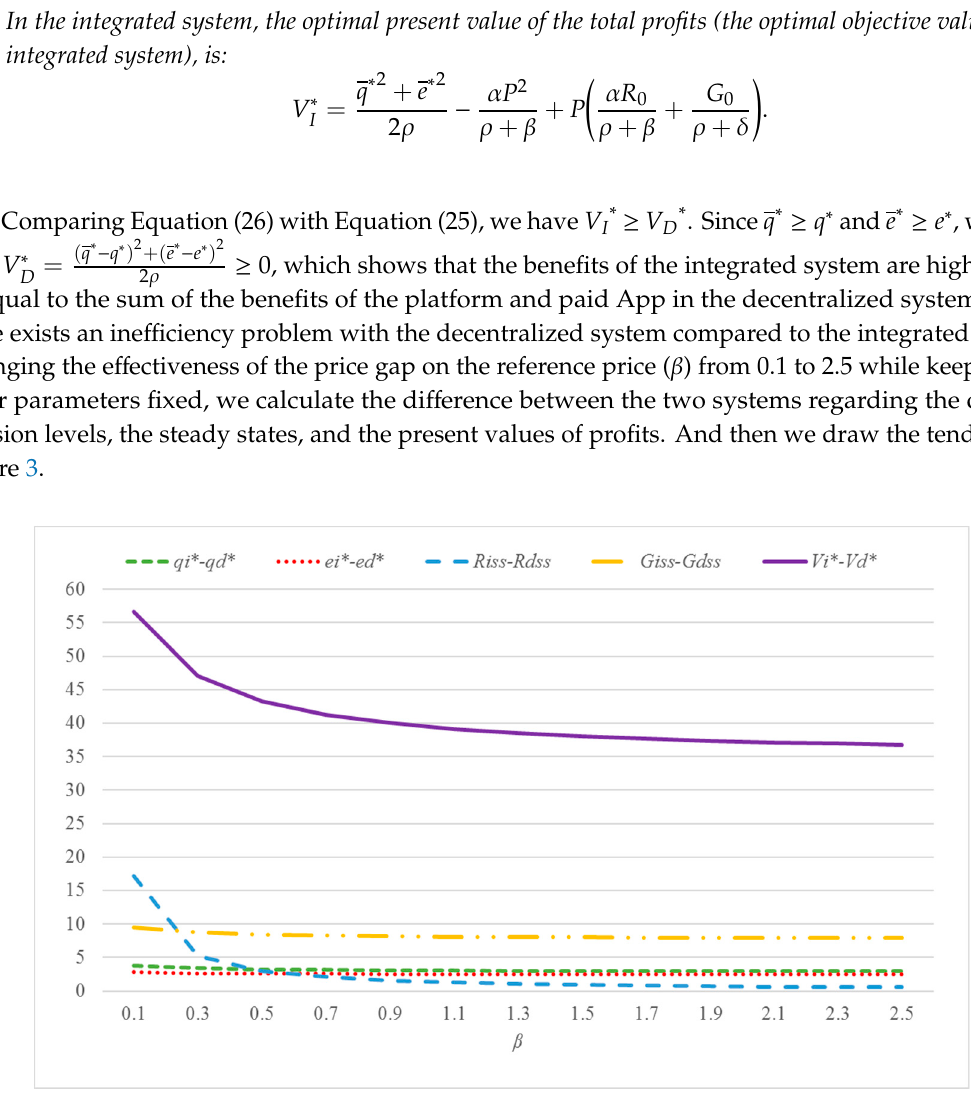
Figure 3. Comparison between the decentralized and integrated systems. Notes: Figure 3 is generated based on P = 10, μ 1 = 0.3, μ 2 = 0.2, θ 1 = 0.2, θ 2 = 0.4, δ = 0.2, α = 0.3, η 1 = 0.3, η 2 = 0.4, λ = 0.35, ρ = 0.2, R 0 = 20, and G 0 = 200.